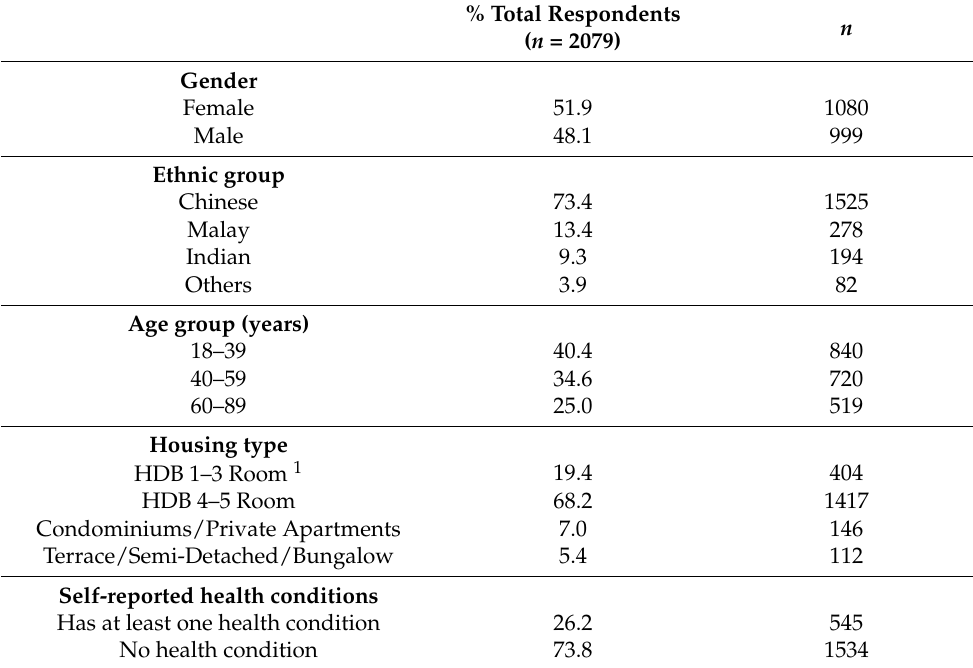
Table 1. Demographic distribution of the respondents in the food consumption